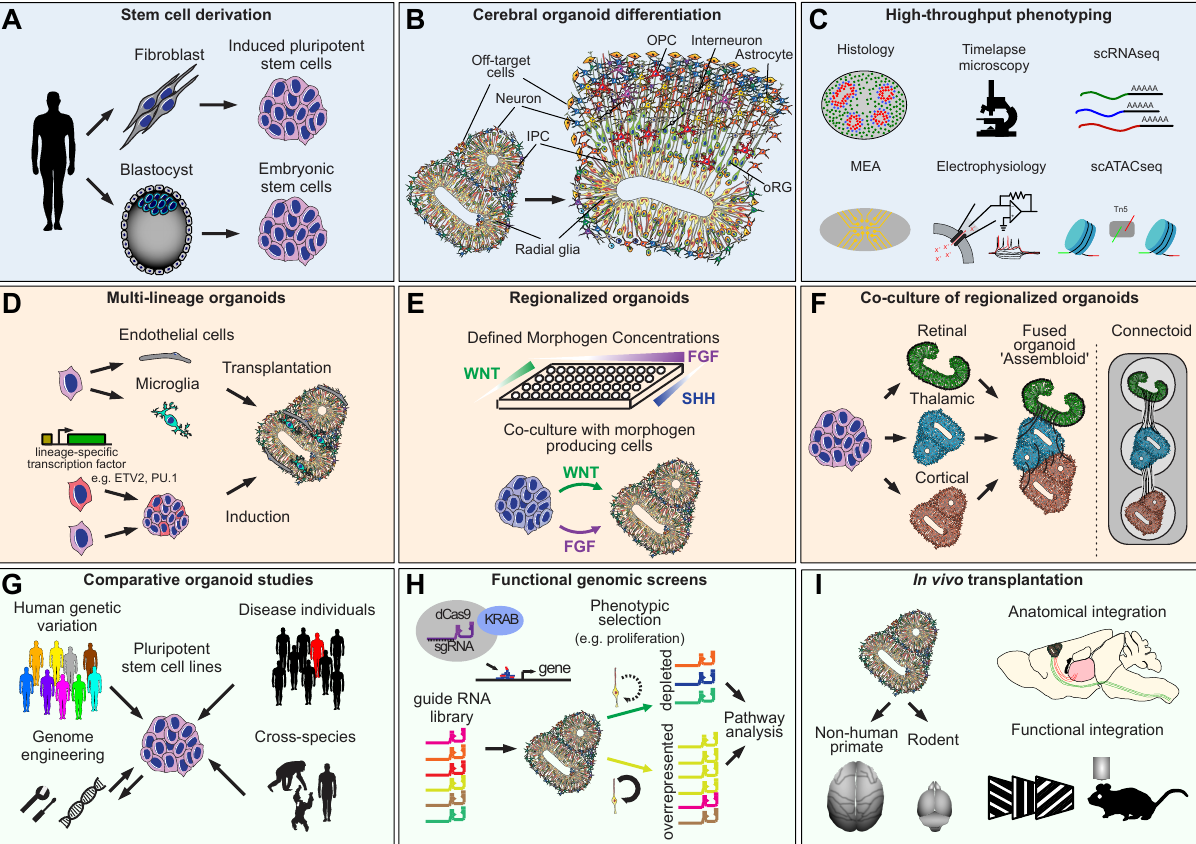
Figure 1. Derivation, refinement, and applications of cerebral organoid technologies. ( A )